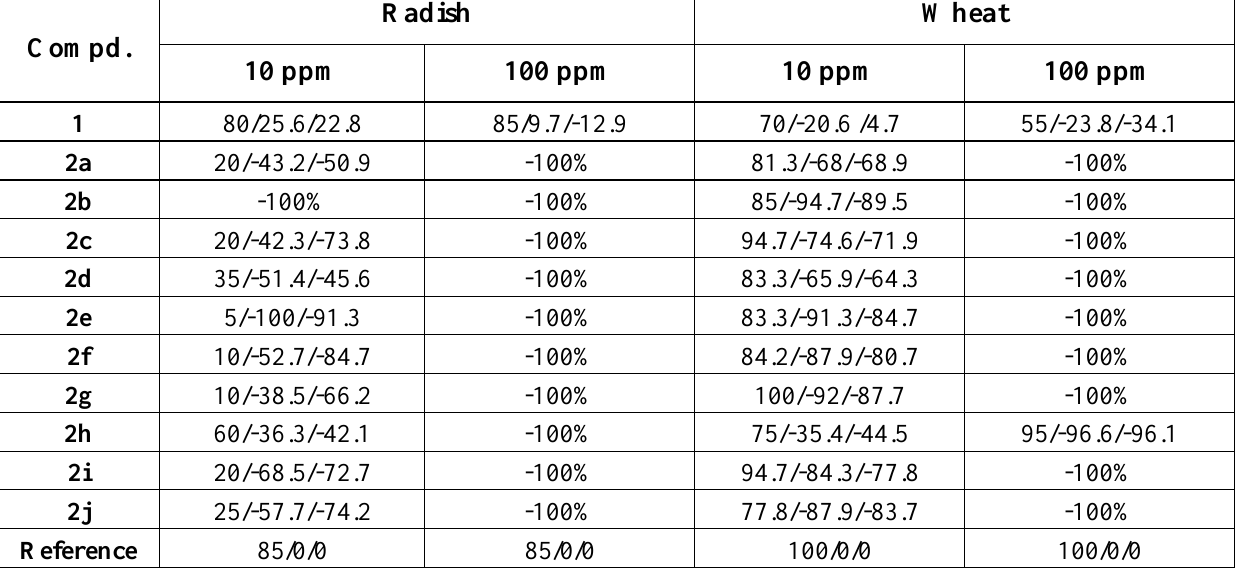
Table 1. Plant growth regulating activities of compounds 1,